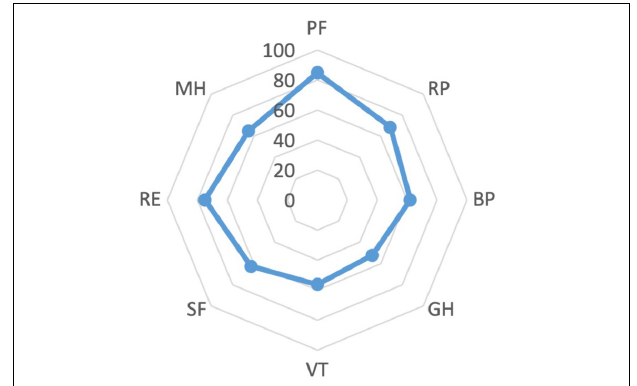
FIGURE 1 | Scores of the single items of